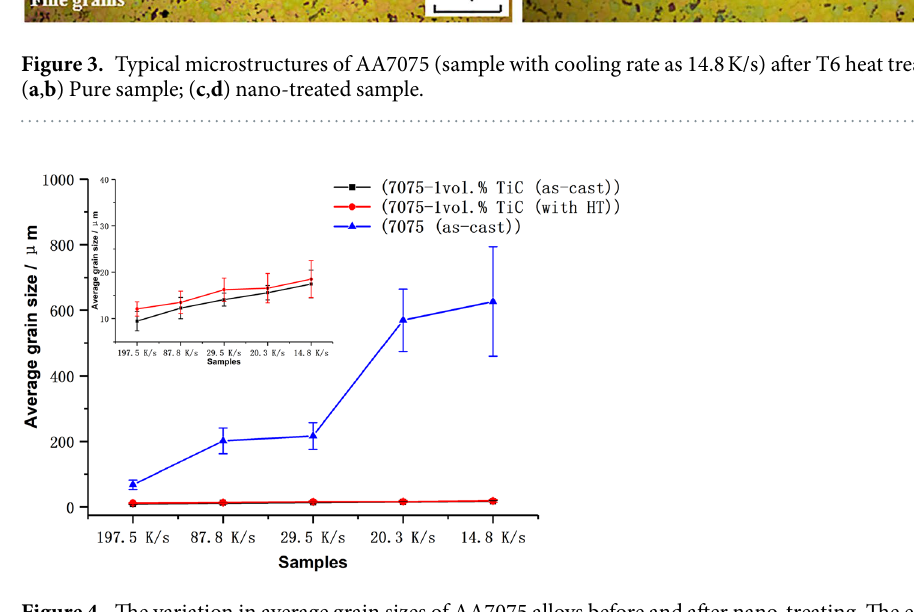
by nano-treatment shows an average grain size of 18.5 ± 4.0 µ m, which is quite similar to that of the as-cast Fig. 4. Based on this thermal stability study, it can be speculated that the nano-treatment provides new opportu- nities for high performance and thermally stable Al alloys. Mechanical properties of AA7075 before and after nano-treating. With the excellent microstruc- tural refinement through nano-treatment, the mechanical properties of AA7075 were also improved. The tensile data of series of AA7075 alloys can be found as Supplementary Fig. S1. As shown in Fig. 5, the Vickers hardness of